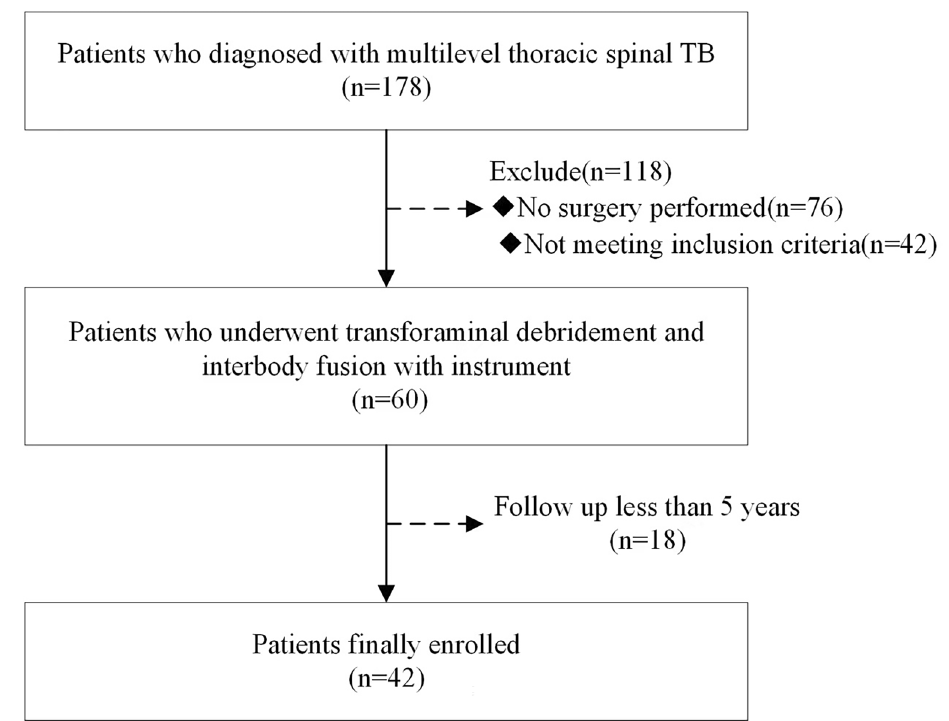
Figure 1. Flow chart of the patients meeting inclusion and exclusion